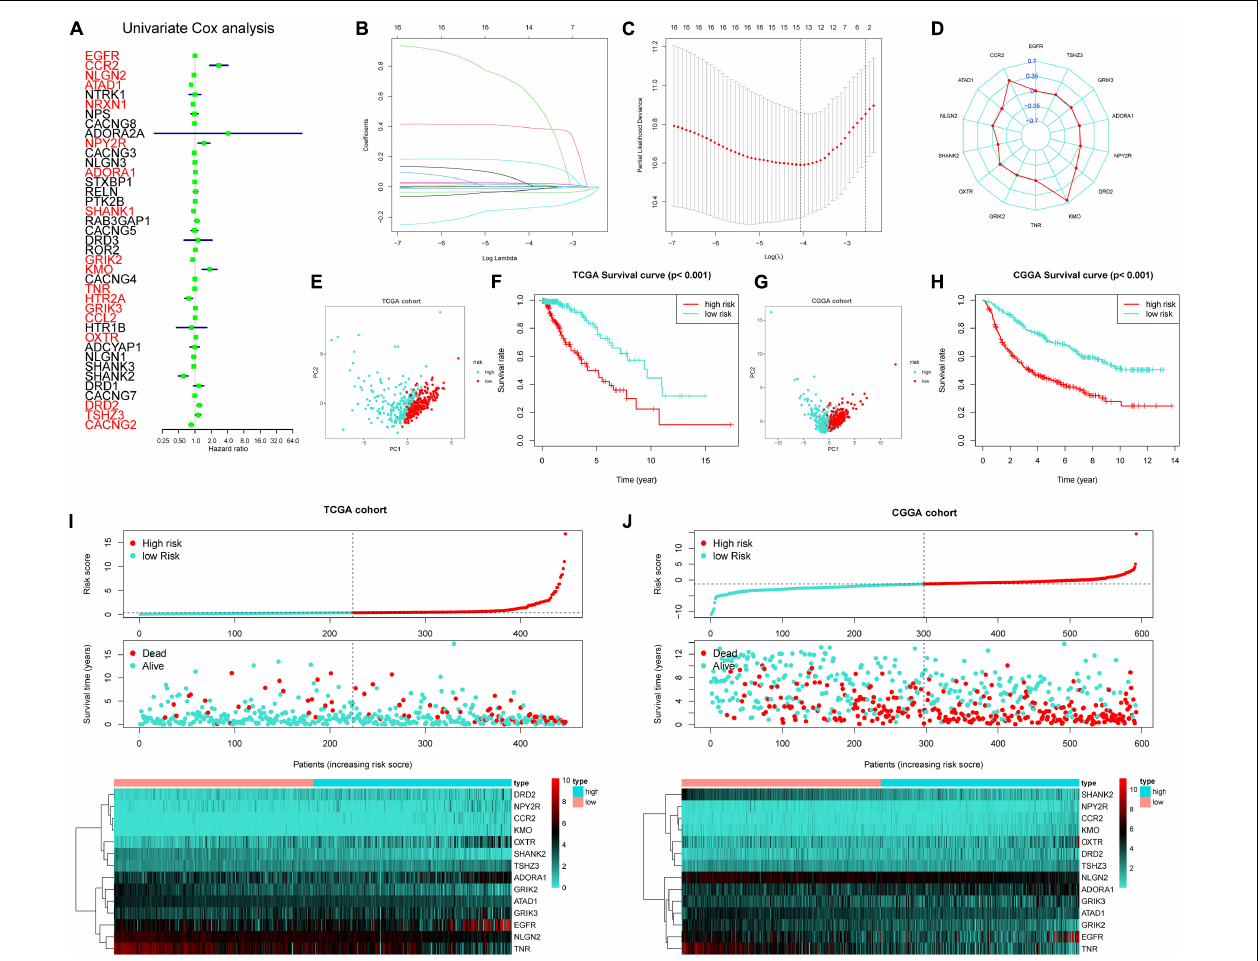
FIGURE 2 | Construction of 14-genes glutamatergic synapse-related risk signature (GSRS). (A) Forest plot for the survival analysis of LGG patients using a univariate Cox model after adjustment for GSRGs; red color represents p < 0.05. (B) The craft plot for partial likelihood deviance in LASSO, different colors represent different genes in GSRS. (C) Partial likelihood deviance as a function of regularization parameter λ in the training dataset. Each red point marks a λ value along regularization paths, and gray error bars represent confidence intervals for the cross-validated error rate. The left vertical dotted line marks the minimum error, whereas the right vertical dotted line marks the most significant λ value, the error of which is within 1 SD of the minimum. The horizontal row of numbers above the plot marks the gene number in each condition upon shrinkage and selection based on linear regression. (D) Radar diagram of efficiency of the 14 genes in GSRS; the closer the red dot is to the outside, the greater the value it represents. (E) Principal component analysis (PCA) of LGG samples in TCGA; dots in turquoise represent samples in high-risk groups and dots in red represent samples in low-risk groups. (F) Overall survival analysis of risk score for LGG patients in TCGA. (G) PCA in